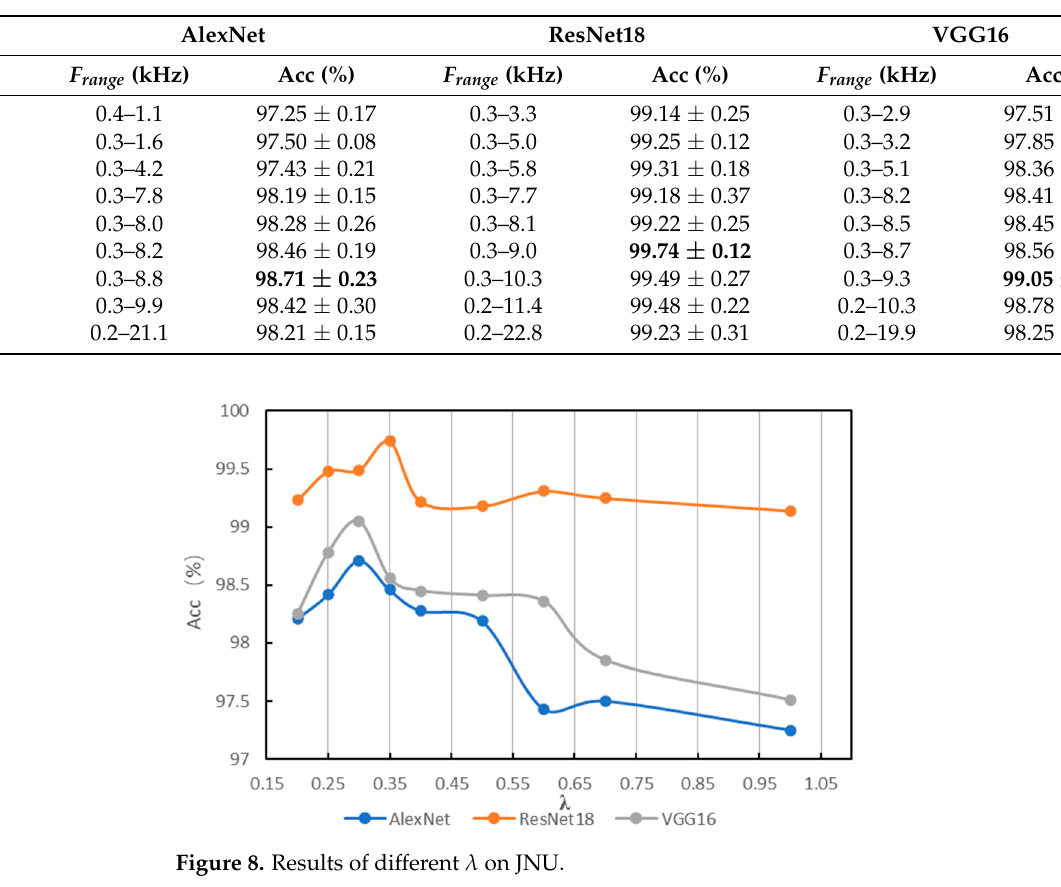
Figure 8. Results of different λ on JNU.